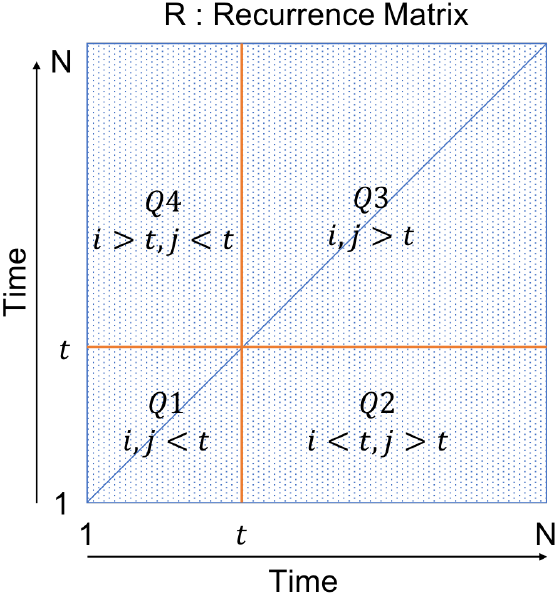
Figure 2. Quadrant Scan principle: at each time index t , the recurrence plot is divided into four quadrants. The value of the Quadrant Scan at t is evaluated by comparing the recurrence point’s density of quadrants Q 1 and Q 3 against the point’s density in all